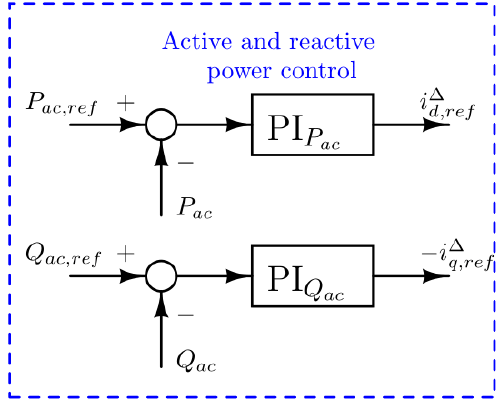
Figure 5. Active and reactive power PI